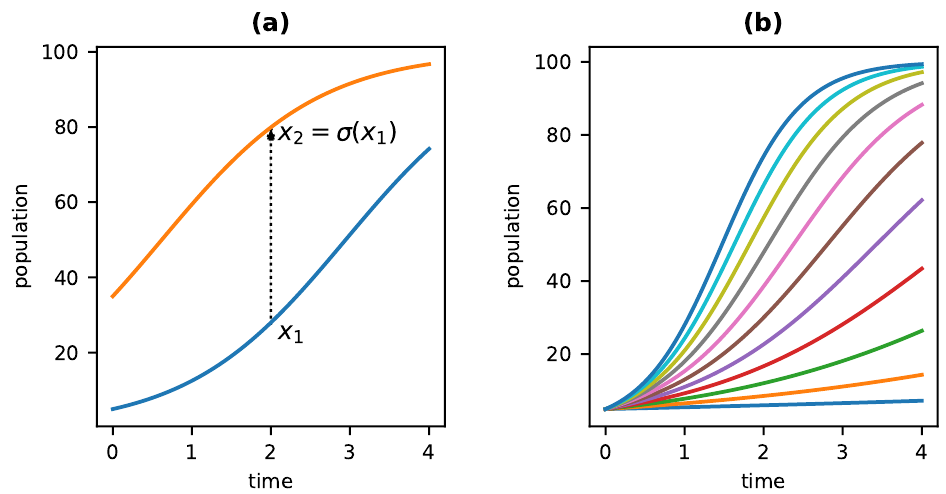
Figure 1. ( a ) Dynamical symmetries of the logistic equation, ˙ x = rx ( 1 − x ) . Each curve is a trace of population over time for the same logistic model ( r = 1, k = 100) starting from two different initial populations (5 and 35). The function that maps each point on the lower curve (such as x 1 ) to the point on the upper curve corresponding to the same elapsed time ( x 2 ) is a dynamical symmetry of the system. In other words, this function, σ , is such that it does not matter whether we allow the system to evolve for some amount of time ∆ t and then apply σ or first apply σ and then evolve through ∆ t ; we end up at the same point on the upper curve in either case. ( b ) Variation within a dynamical kind. Each curve shows the evolution of a logistic system with k = 100 from an initial population of 5 and a distinct value of r (between 0.1 and 11). All of these logistic systems exhibit exactly the same set of dynamical symmetries, and are thus in the same dynamical